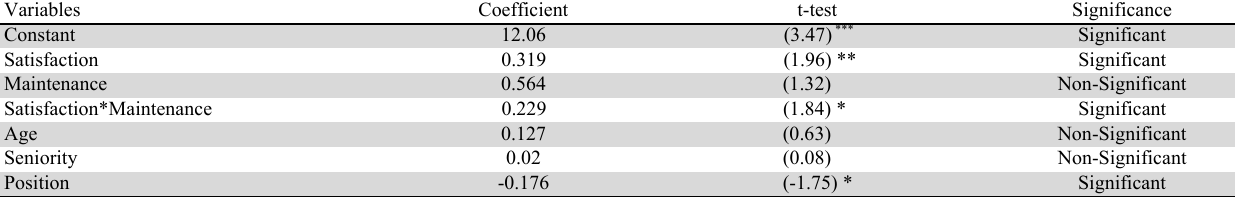
Dependent variable: Task performance